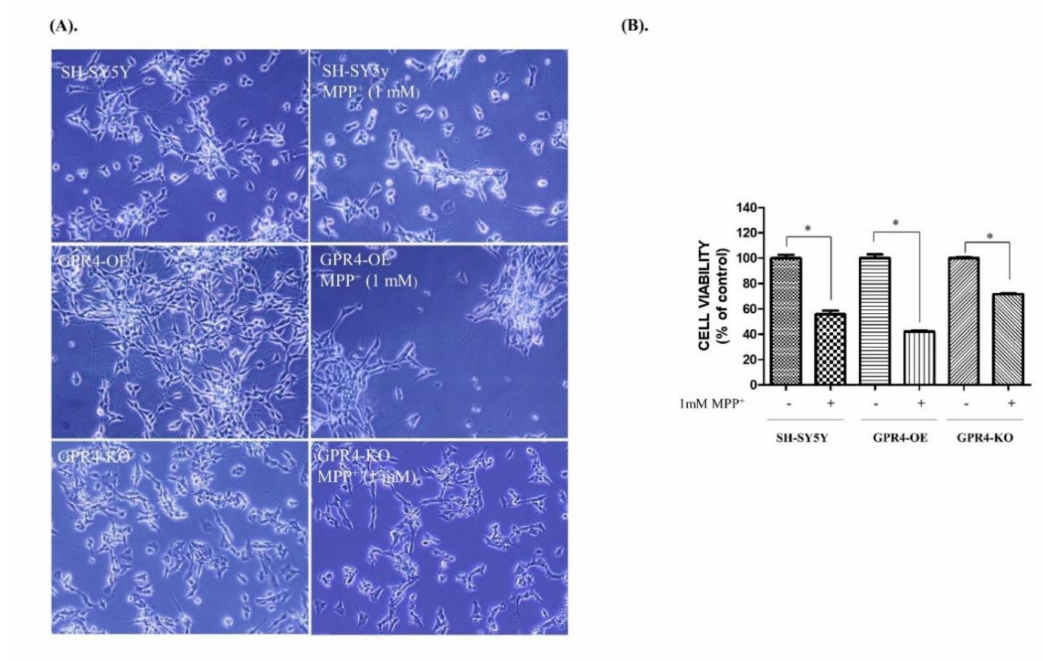
Figure 2. The cellular viability and morphology of MPP + -treated SH-SY5Y cells that were stably GPR4-overexpressing (GPR4-OE) or GPR4-knockout (GPR4-KO). 24 h serum-starved SH-SY5Y cells were treated with MPP + (1 mM) for 24 h in serum-free culture media. ( A ) The morphology of SH-SY5Y GPR4-OE and GPR4-KO cells was observed through bright-field microscopy. ( B ) Cell viability was evaluated using an MTT assay. Mean ± SEM ( n = 3) was employed to express the data. Tukey’s multiple comparison test was performed using a one-way ANOVA. Each * p < 0.05 refers to the other sample concentrations compared with the control